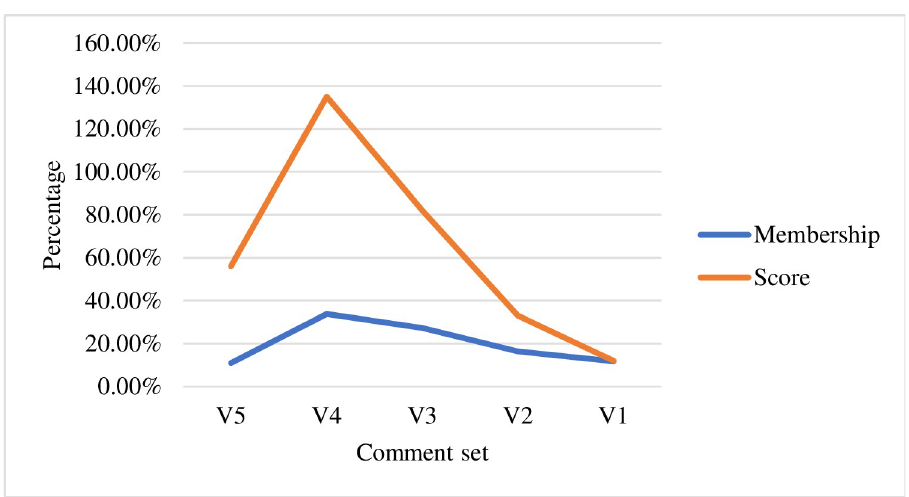
Fig 6. Model innovation influence factor comprehensive evaluation score curve.